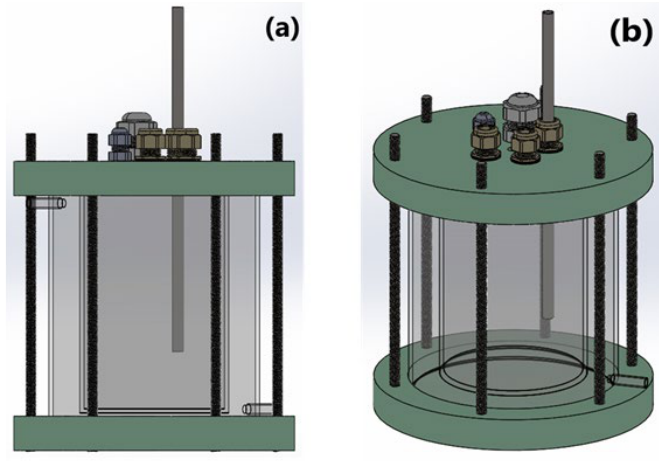
Figure 1. 3D bioreactor model. ( a ) Frontal view and ( b ) isometric view. Source: elaborated by the author.